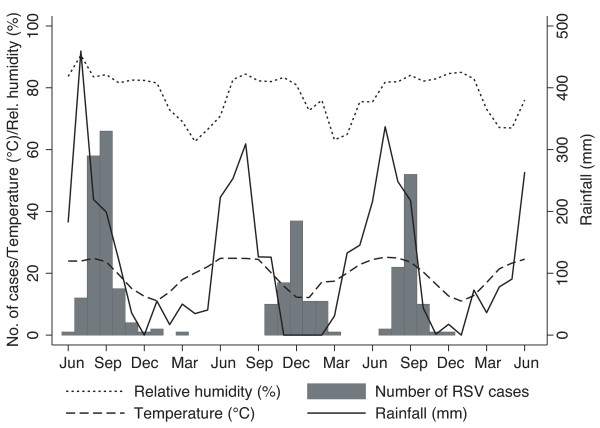
Monthly number of RSV infections in children aged 2 to 35 months with community-acquired pneumonia from 29 June 2004 to 30 June 2007, in Bhaktapur, Nepal, depicted with monthly variation of relative humidity, rainfall and temperature. The mean daily measurement for the month was used for relative humidity and temperature, while rainfall was calculated as the total measurement for the month.